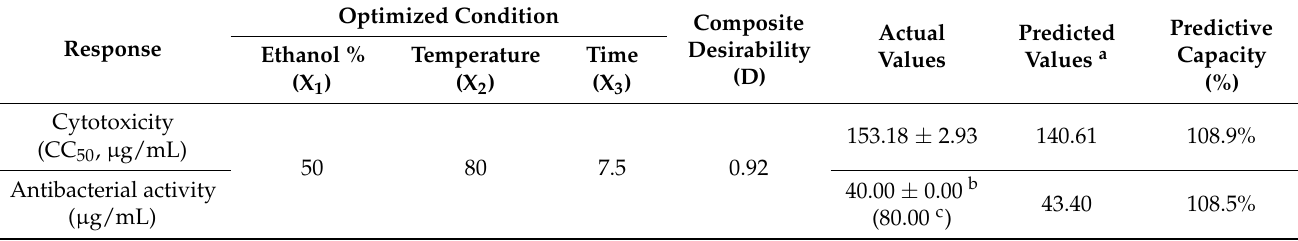
Table 4. Comparison between actual value and predicted value determined under optimal conditions.